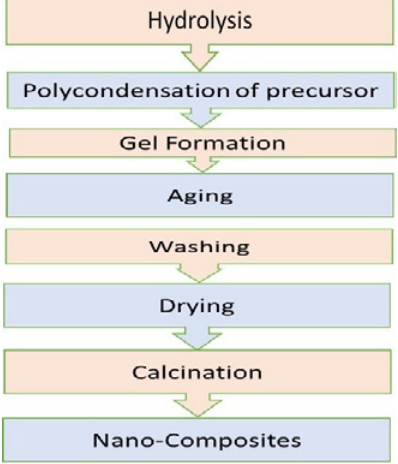
Fig. 5. A schematic flowchart of the sol-gel